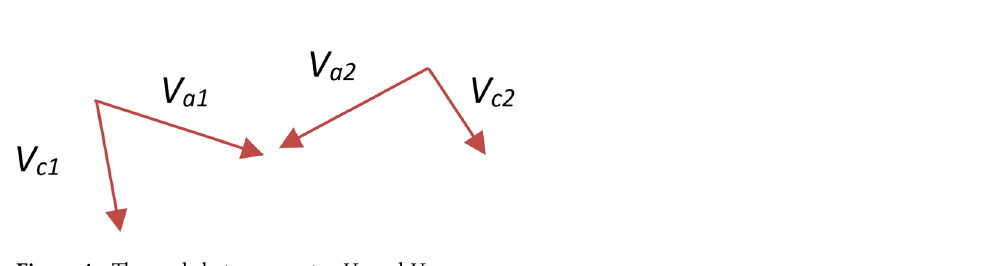
Figure 4. The angle between vector Va and Vc